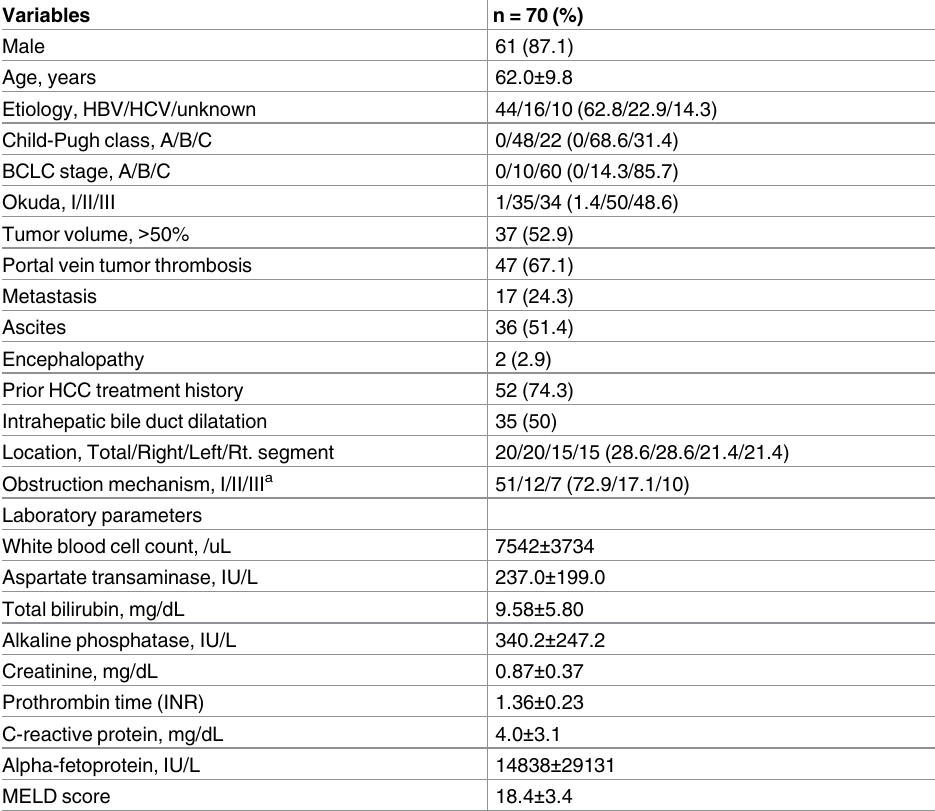
Table 1. Baseline